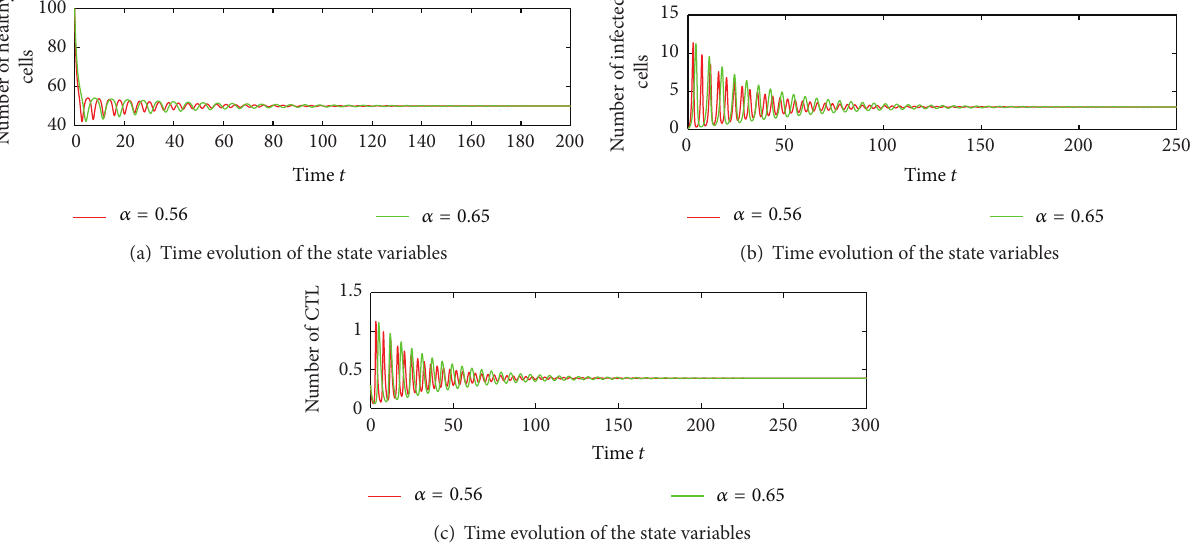
Figure 2: The diagrams show the time evolution of the trajectory of system (5) for healthy cells 𝑥(𝑡) , infected cells 𝑦(𝑡) , and the CTL 𝑧(𝑡) , respectively, with respect to 𝛼 = 0.56 and 𝛼 = 0.65 , in condition of 𝐷(𝑃) < 0 . The red lines correspond to 𝑥(𝑡) in (a), 𝑦(𝑡) in (b), and 𝑧(𝑡) in (c) for 𝛼 = 0.56 ; the green lines correspond to 𝑥(𝑡) in (a), 𝑦(𝑡) in (b), and 𝑧(𝑡) in (c) for 𝛼 = 0.65